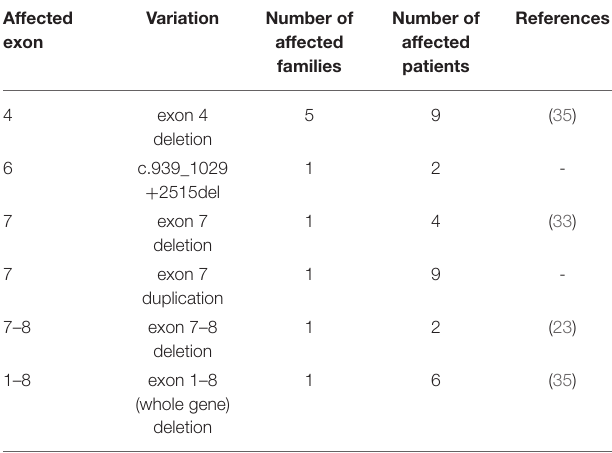
TABLE 5 | Large deletions/duplication identified in the SERPING1